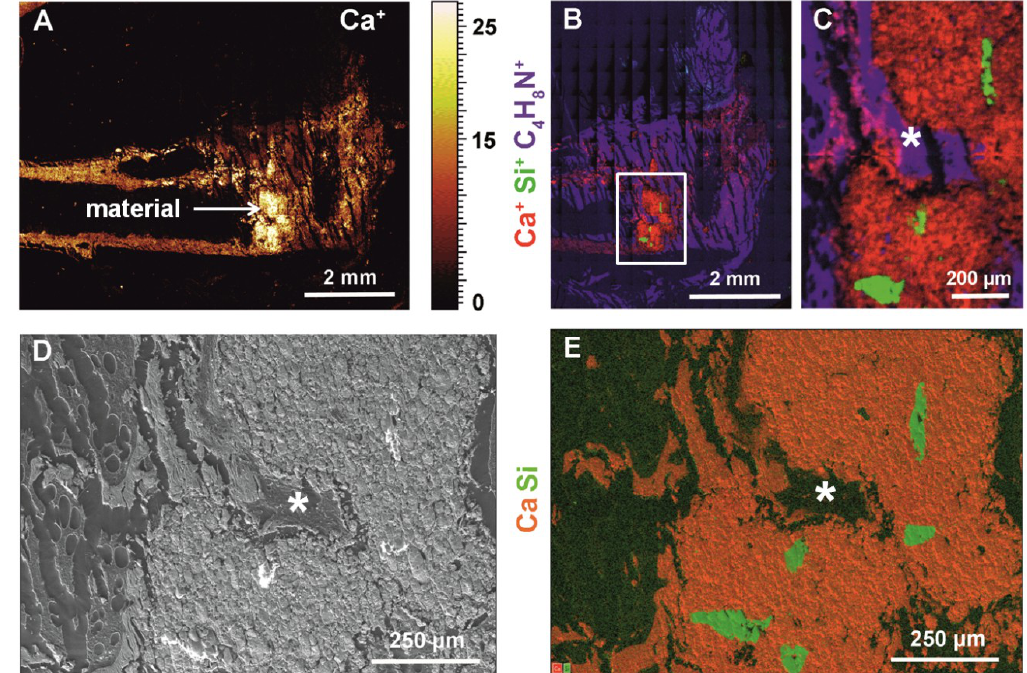
Figure 5. ToF-SIMS, HR-SEM and EDS images of bone cross sections: ( A ) ToF-SIMS overview image of calcium mass distribution within the femur and cement/MBG composite, the lighter the color the higher the calcium mass distribution indicated by the scale next to the image ( B , C ) ToF-SIMS mass images showing calcium (red, Ca + ), collagen (blue, C 4 H 8 N + ) and silicon (green, Si + ), ( C ) close-up of cement/MBG composite indicated with a white box in B, the different colors of the element symbols at the margin of figures B, C and E correspond to colors seen in images, ( D ) HR-SEM image, ( E ) EDS mapping of the cement/MBG composite in red and MBG particles in green. * in C, D and E indicate newly formed bone within a pore that developed after MBG particles dissolved.